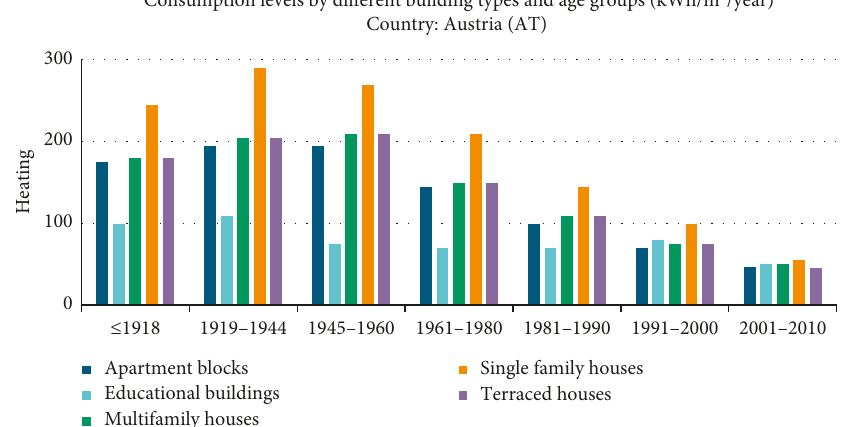
Figure 1: European BPIE database data (taking heating energy consumption for example).